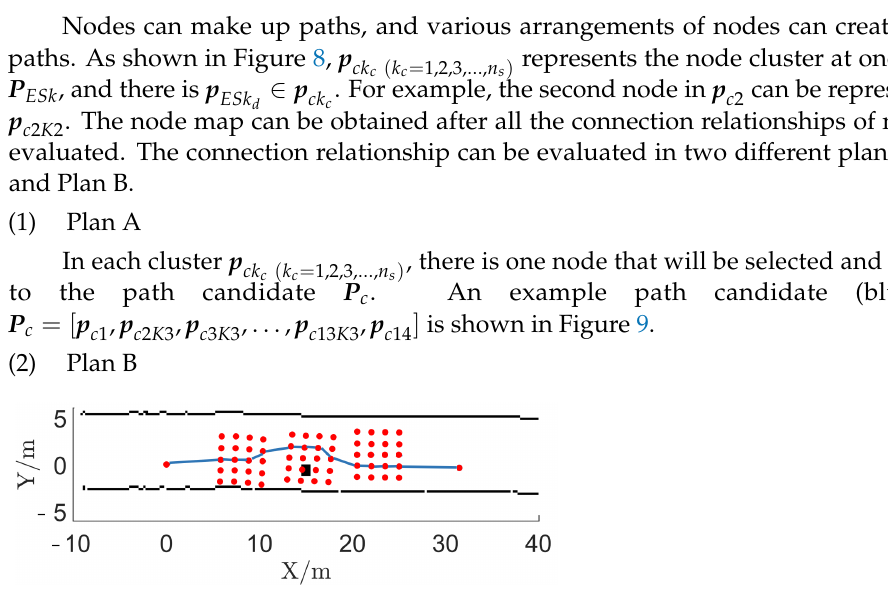
Figure 10. An example of